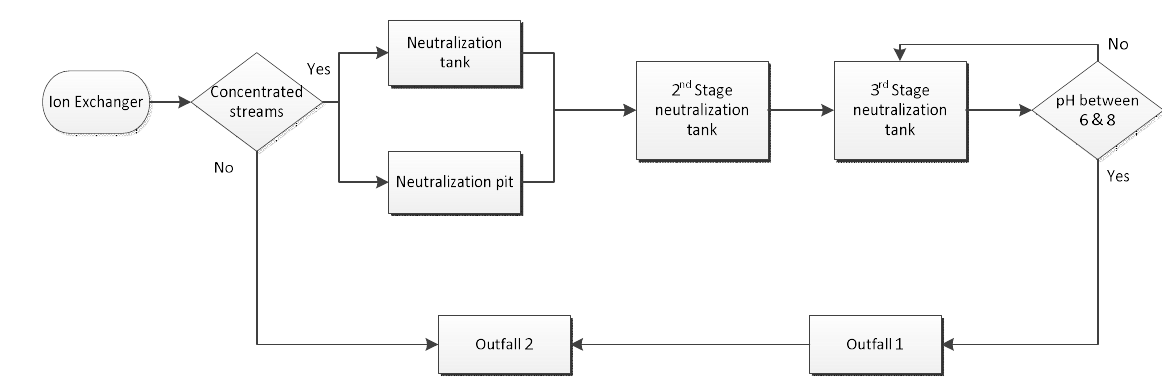
Figure 2. Second neutralization process. Neutralization is done in a continuous manner with the three neutralization tanks in series.